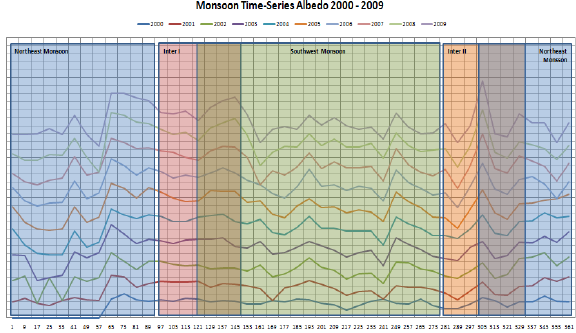
Figure 6. Monsoon Albedo Variation However, from year 2005 to 2009, the graph shows some rapid increased of albedo (see Day 121-145). A similar pattern of rise and fall value of albedo can be seen in Day 241 to Day 249. In Northeast Monsoon (wet season) which starts from Day 305 and fall back to March at Day 89 depict some extreme rise and fall which correspond to the nature of the season where heavy rainfall, variations of windspeed and it is a cold surges period especially at the east coast region of the study area.